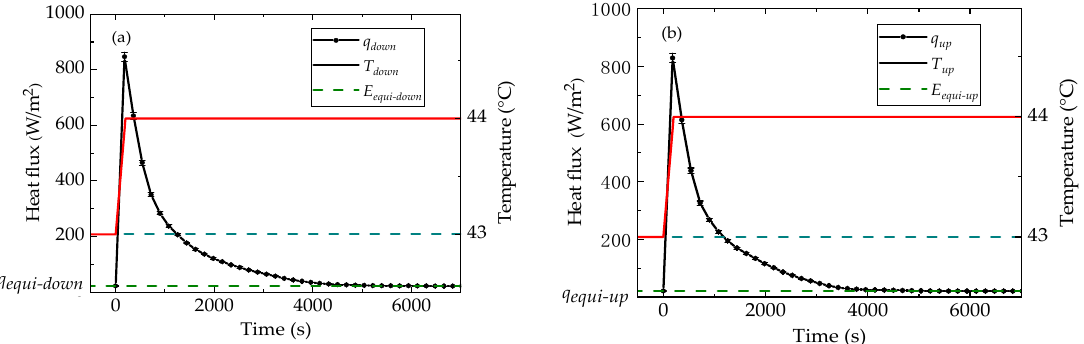
Figure 10. Curves of temperature step and heat flow values on both plates. ( a ) Bottom plate. ( b ) Top plate.